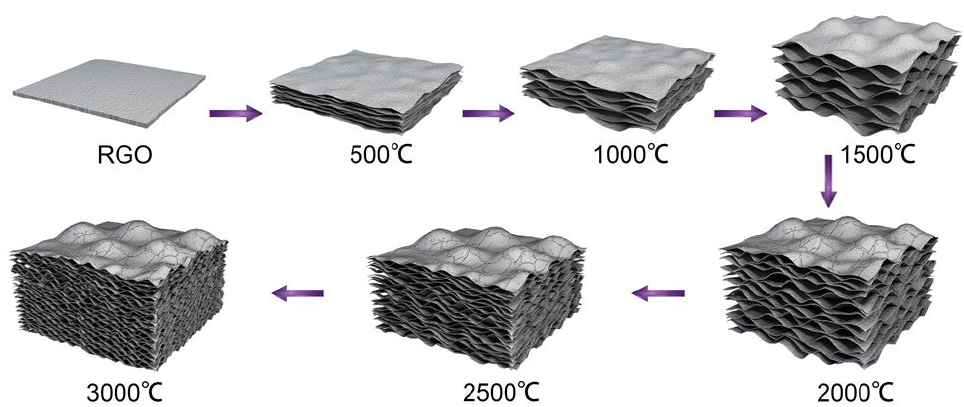
Figure 2. Formation of graphene aerogel films (GAFs).